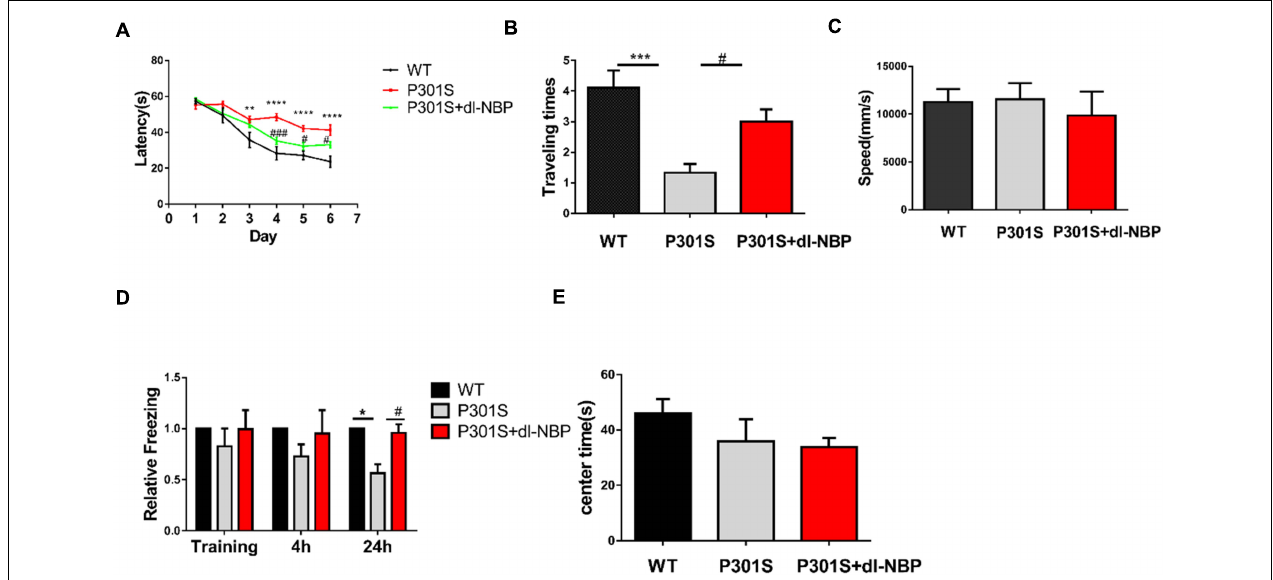
FIGURE 1 | dl-NBP treatment ameliorates behavioral deficits in P301S mice. (A) Escape latency to reach the platform in the training phase of the Morris water maze (MWM) over 6 consecutive days. The spatial learning ability of P301S mice was declined compared with WT mice, and it was alleviated in P301S + dl-NBP mice. (B) The numbers of entry to the platform zone of the three groups in the probe trial of the Morris water maze test. (C) Swimming speed to test the motor ability of the three groups of mice in the Morris water maze test. (D) Relative freezing time at 4 and 24 h during contextual fear conditioning test. dl-NBP ameliorated contextual memory deficits at 24 h during contextual fear conditioning test in P301S mice. (E) Time spent in the center of the open field during the open-field exploration of the three groups. All results were presented as mean ± SEM ( n = 8). * P < 0.05, ** P < 0.01, *** P < 0.001, **** P < 0.0001, WT mice vs. P301S mice; # P <